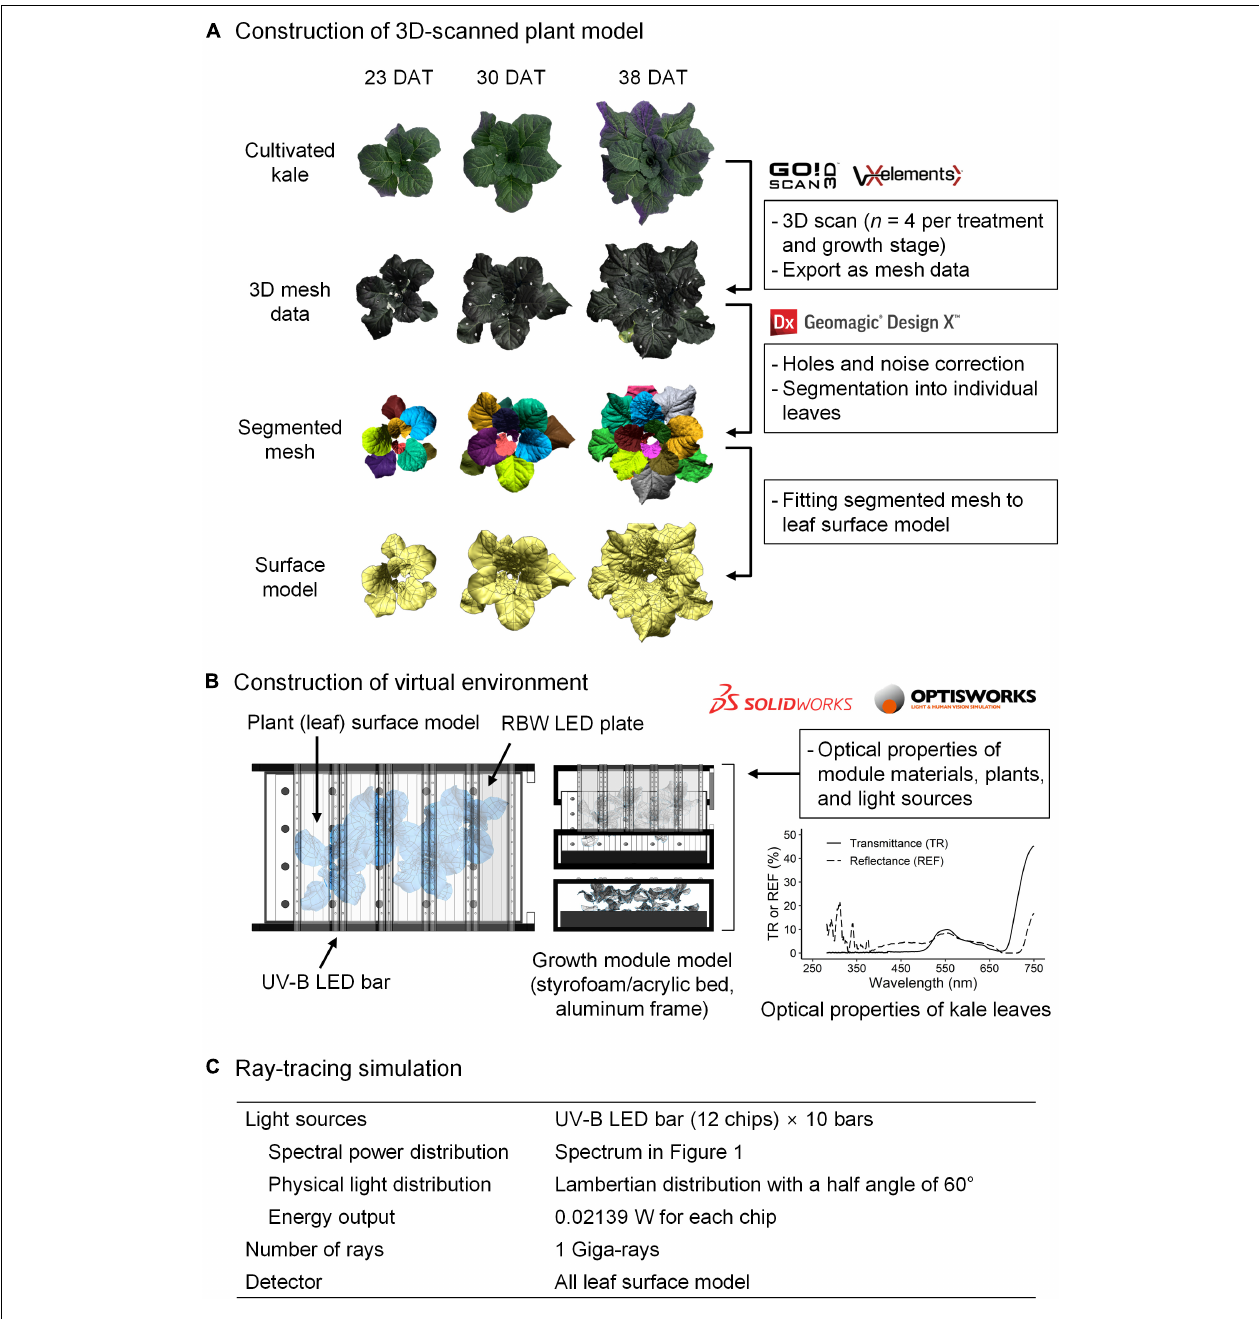
FIGURE 2 | Schematic diagram of 3D scanning to optical simulation for radiation interception analyzed in kale plants. After the construction of a 3D-scanned plant model (A) , the virtual environment for simulation (B) consisted of a 3D model of the growth module, light sources, and plants with actual dimensions and arrangement. A ray-tracing simulation (C) was conducted with these parameters. TR, transmittance; REF,